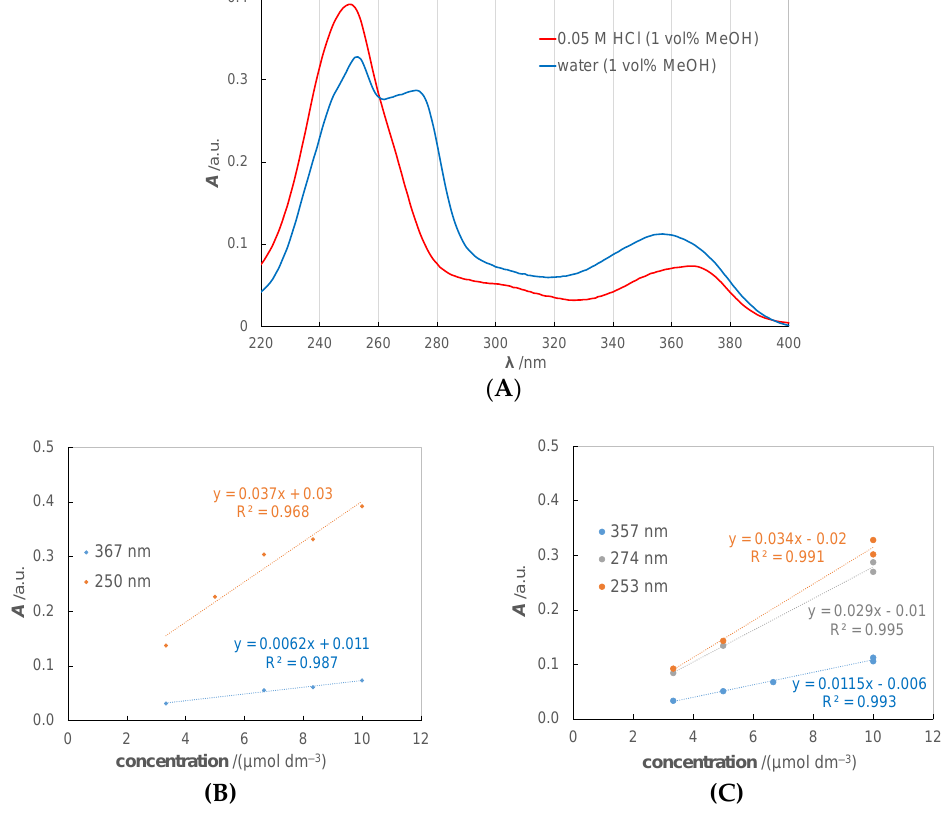
Figure 2. ( A ): UV-vis spectra of 10 µM ellagic acid in 0.05 M HCl solution (red line) and in water (blue line). Corresponding calibration plots in the acid ( B ) and in the near-neutral solution ( C ). In all analysed samples 1 vol% methanol is invariably present.